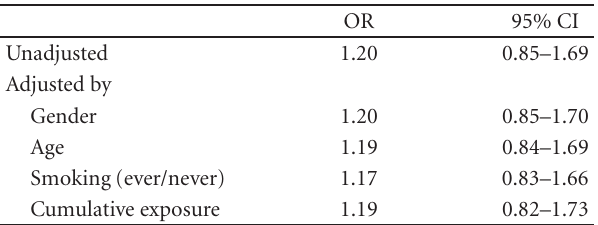
Table 3: Risk of asbestosis for the iNOS LL genotype versus the combined SL and SS genotypes after adjustment by gender, age, smoking, and cumulative asbestos